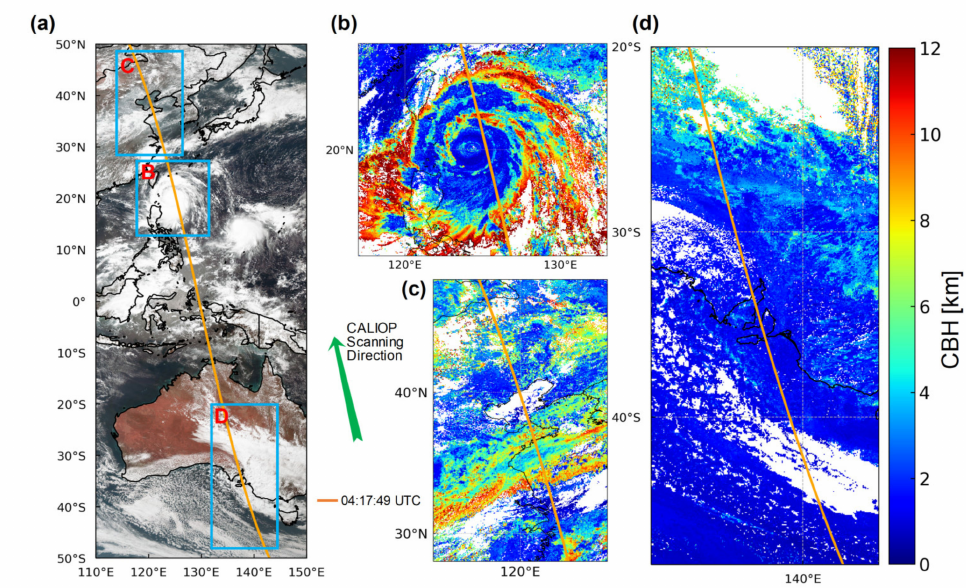
Figure 4. Case study of Super Typhoon Meranti and low/high clouds on 13 September 2016: ( a ) AHI Natural True Color images starting at 05:00:41 UTC, with the start time and direction indicated in the right-side legends; the orange lines represent the CALIOP scanning tracks. The CBH calculated by the RF-CBH corresponding to areas B, C, and D in panel ( a ) is shown in panels ( b – d